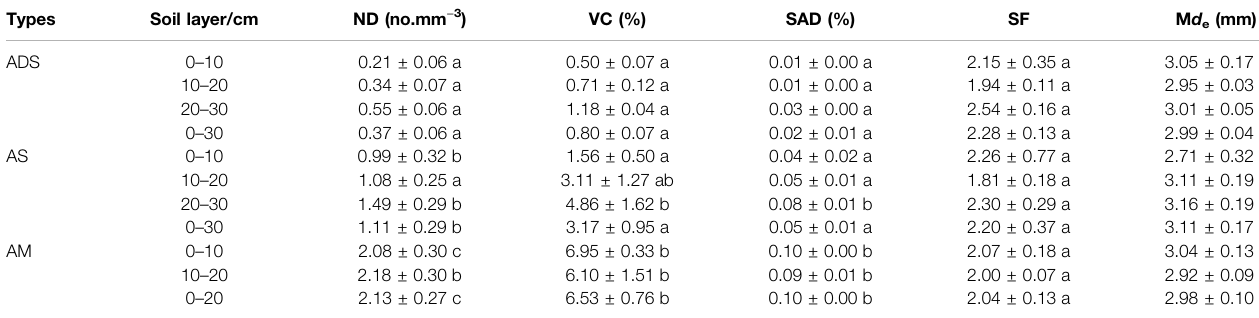
TABLE 2 | Rock fragments characteristics under three vegetation types.